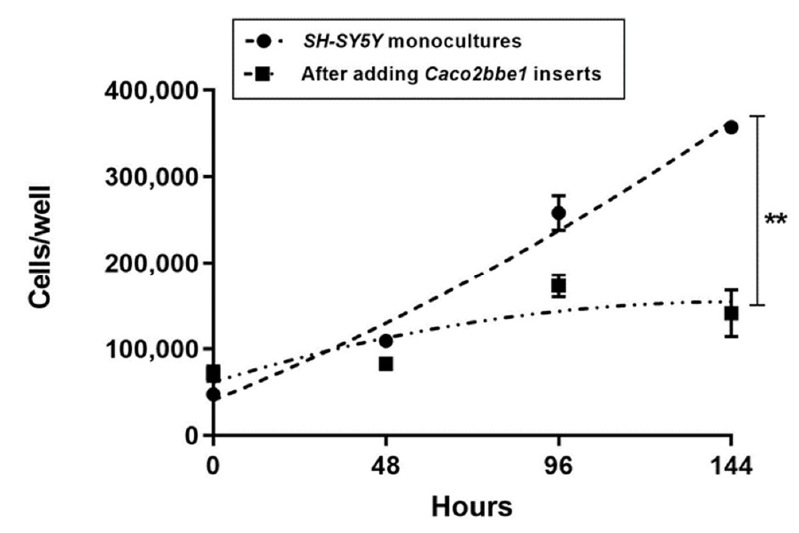
Figure 5. Cytostatic effect of Caco2bbe1 inserts on growth of SH-SY5Y cells. Caco2BBe1 cells were plated on inserts ( n = 25,000/insert) and grown with regular feeding of complete (10% FBS) media, top, and bottom. On day 11, SH-SY5Y cells were plated in separate open 24-well plates ( n = 25,000/well) in complete media. Three days later, both 24-well plates were refed complete media. Immediately afterward, experimental wells received Caco2Bbe1 inserts. The control wells of SH-SY5Y cells remained without inserts (monocultures). Three or more wells per the condition of SH-SY5Y cells were harvested and counted by trypan blue cellometry at 0 (day of combination), 48, 96, and 144 h. Plots are means ± SEMs. The asterisks indicate high statistical difference in cell numbers between the two groups at 144 h ( p < 0.001).